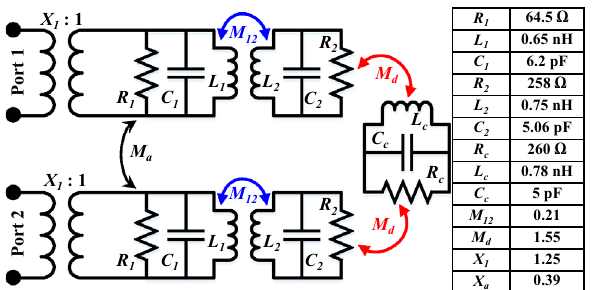
Figure 7. Lumped element model of the proposed wideband implantable MIMO antenna.